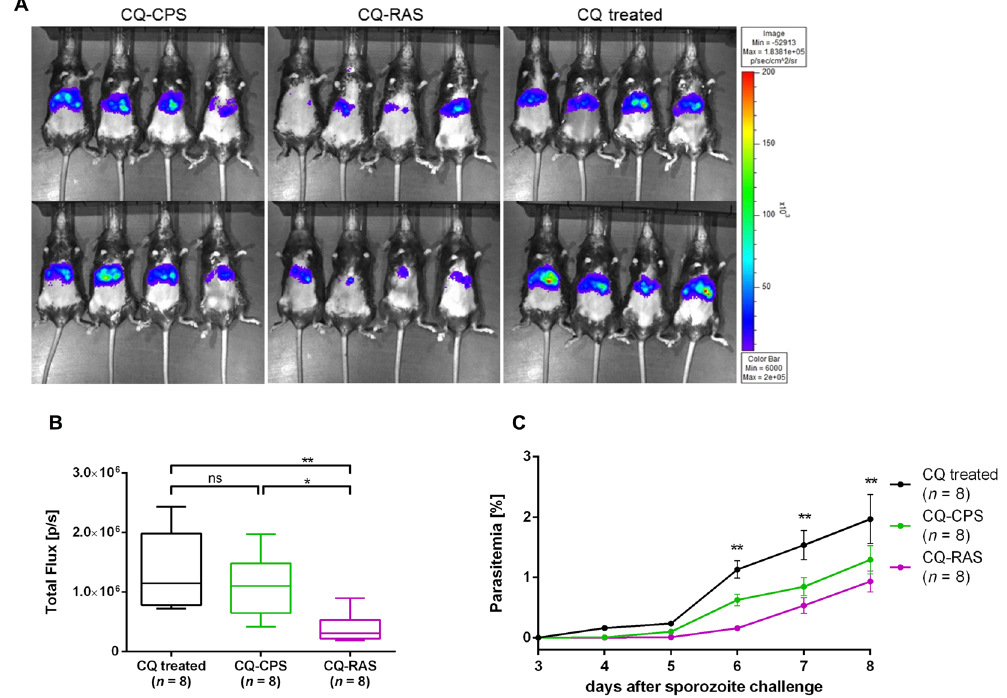
Figure 2. Liver- and blood-stage parasite development after a single RAS or CPS immunization. ( A ) Visualization of in vivo parasite liver load 42 h after i.v. challenge with 10 3 luciferase-expressing Pb ANKA SPZ in previously CQ-CPS (n = 8) or CQ-RAS (n = 8) immunized mice versus CQ treated (n = 8) control animals. ( B ) A single CQ-RAS but not CQ-CPS immunization resulted in reduced parasite liver load in comparison to CQ-treated control mice at 42 h after i.v. challenge with 10 3 luciferase-expressing Pb ANKA SPZ ( * P < 0.05; ** P < 0.01, Tukey’s multiple comparisons test, 1-way ANOVA). ( C ) CQ-RAS (n = 7, one mouse who did not develop parasitemia was excluded from the analysis) and CQ-CPS (n = 8) immunization resulted in significantly impaired blood-stage development on days 6 to 8 post challenge with 10 3 Pb ANKA SPZ i.v. in comparison to CQ-treated (n = 8) control mice ( ** P < 0.01, repeated measures ANOVA. Within the model, parasitemia on days 6, 7 and 8 after challenge were set as depended variables and analyzed with the covariate of d5